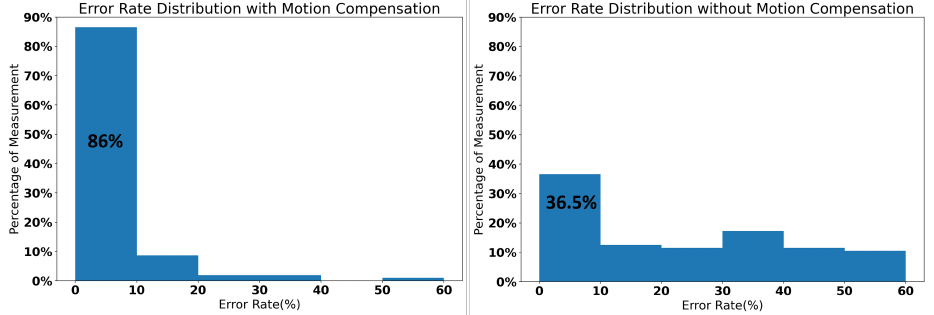
Figure 8. Waterfall diagram of the success rate of the HR measurements under different testing scenarios on highways and local roads.